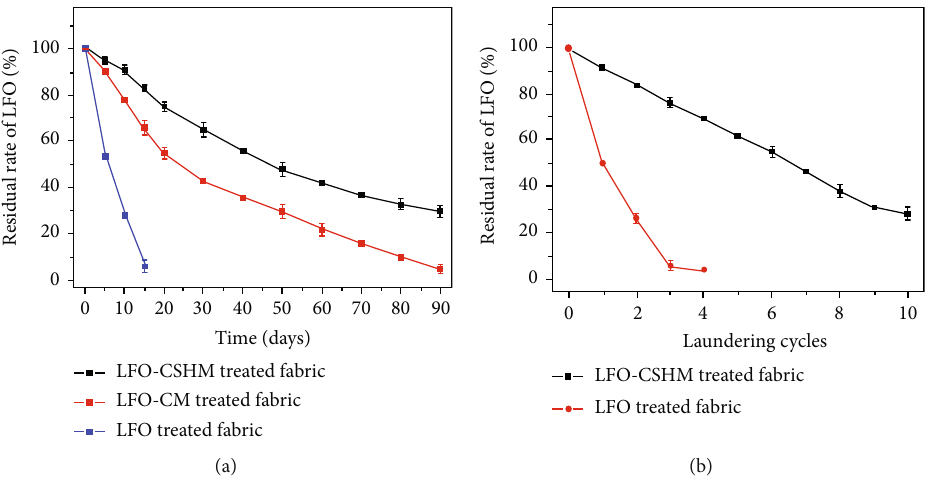
Figure 10: Control release of (a) LFO from LFO-treated, LFO-CM-treated ( 40 % LFO − CM + polysiloxaneresins ) and LFO-CSHM-treated ( 40 % LFO − CSHM + polysiloxane resins ) cotton fabrics. (b) LFO from LFO-treated ( 40 % LFO − CM + polysiloxaneresins ) and LFO-CSHM- treated ( 40 % LFO − CSHM + polysiloxaneresins ) cotton fabrics after repeated laundering [30].